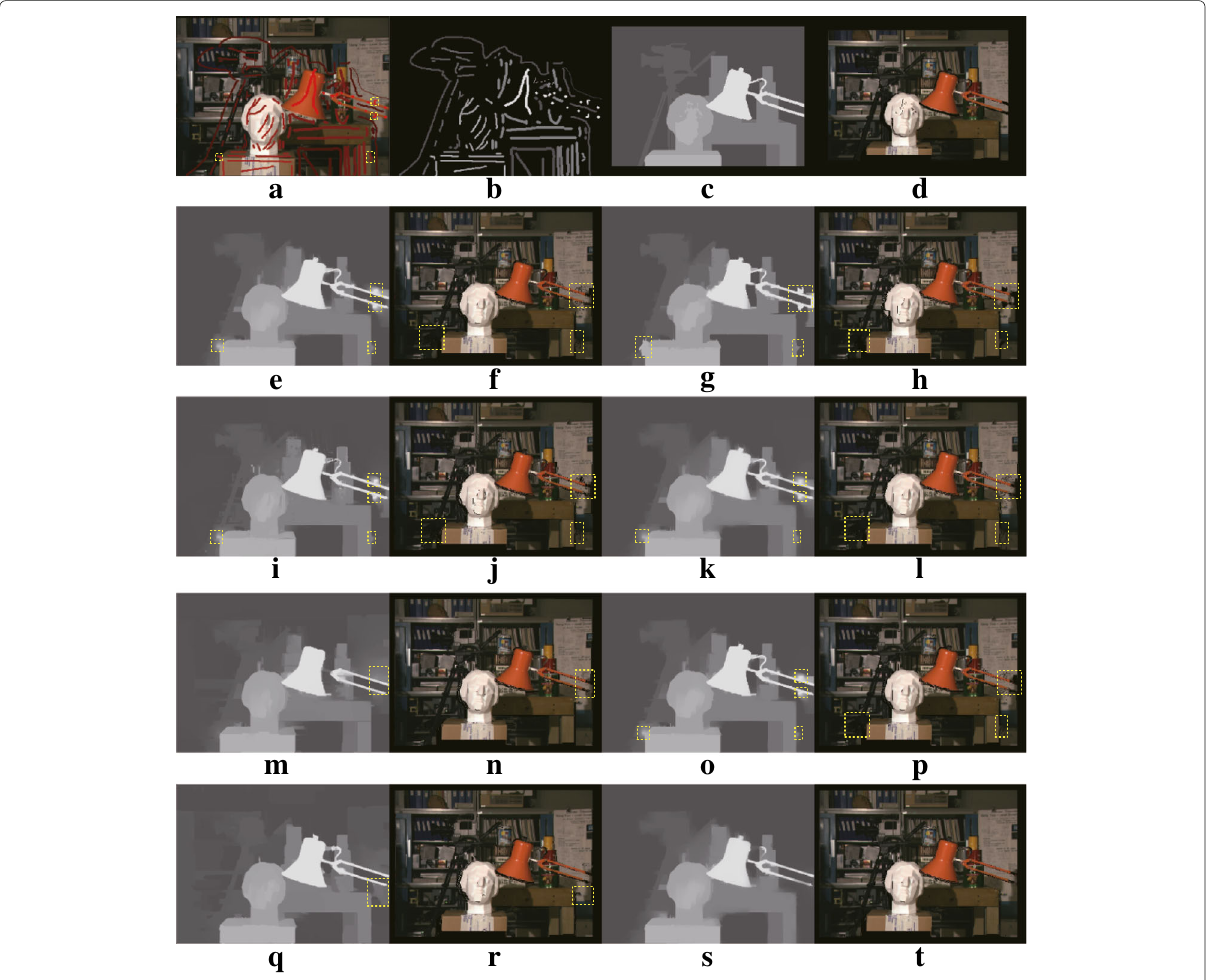
Fig. 13 Results of Tsukuba with cross-boundary input. a User-labeled image. b Sparse depth. c Groundtruth depth. d Synthesized view using c. e Depth of RW. f Synthesized view using e . g Depth of HGR. h Synthesized view using g . i Depth of NRW. j Synthesized view using i . k Depth of OPT. l Synthesized view using k . m Depth of OCP. n Synthesized view using m . o Depth of SDF. p Synthesized view using o . q Depth of (cid:2) 1 . r Synthesized view using q . s Depth of the proposed method. t Synthesized view using s . Please zoom in to see